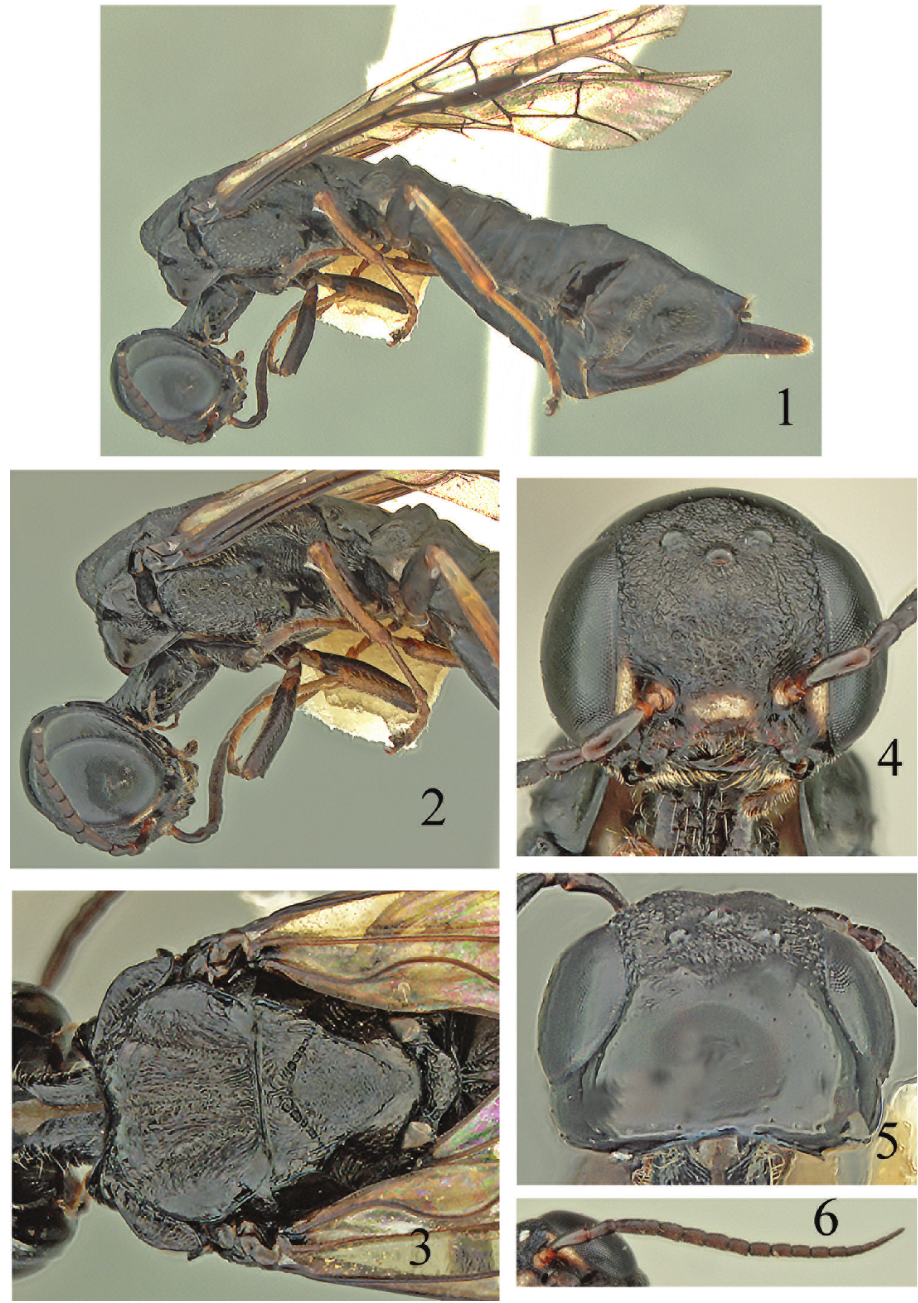
Figures 1–6. Calexiphyda marystellae . 1 Lateral 2 Head and thorax, lateral 3 Thorax, dorsal 4 Head front 5 Head dorsal 6